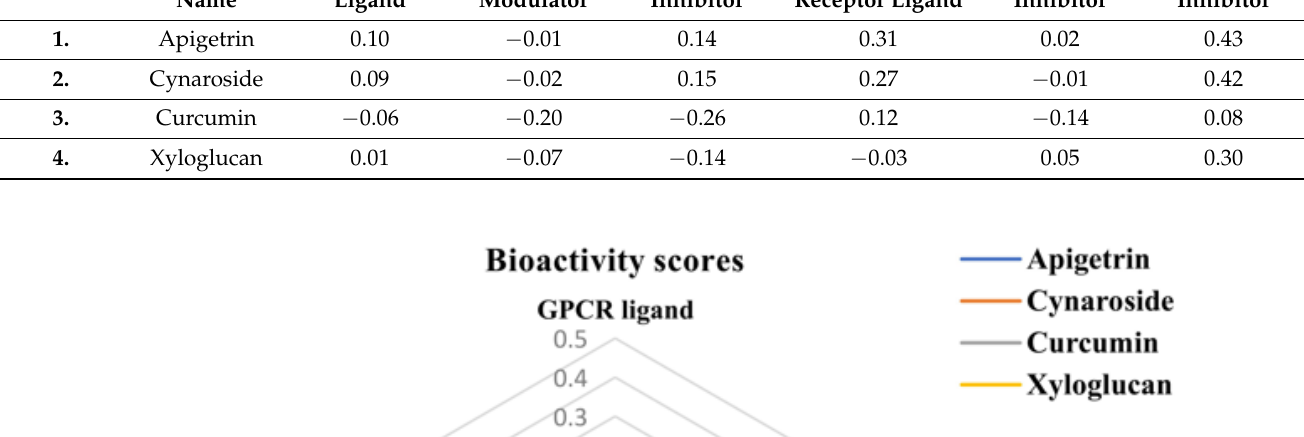
Table 3. Bioactivity score of the compounds according to Molinspiration Cheminformatics software. Sl No.